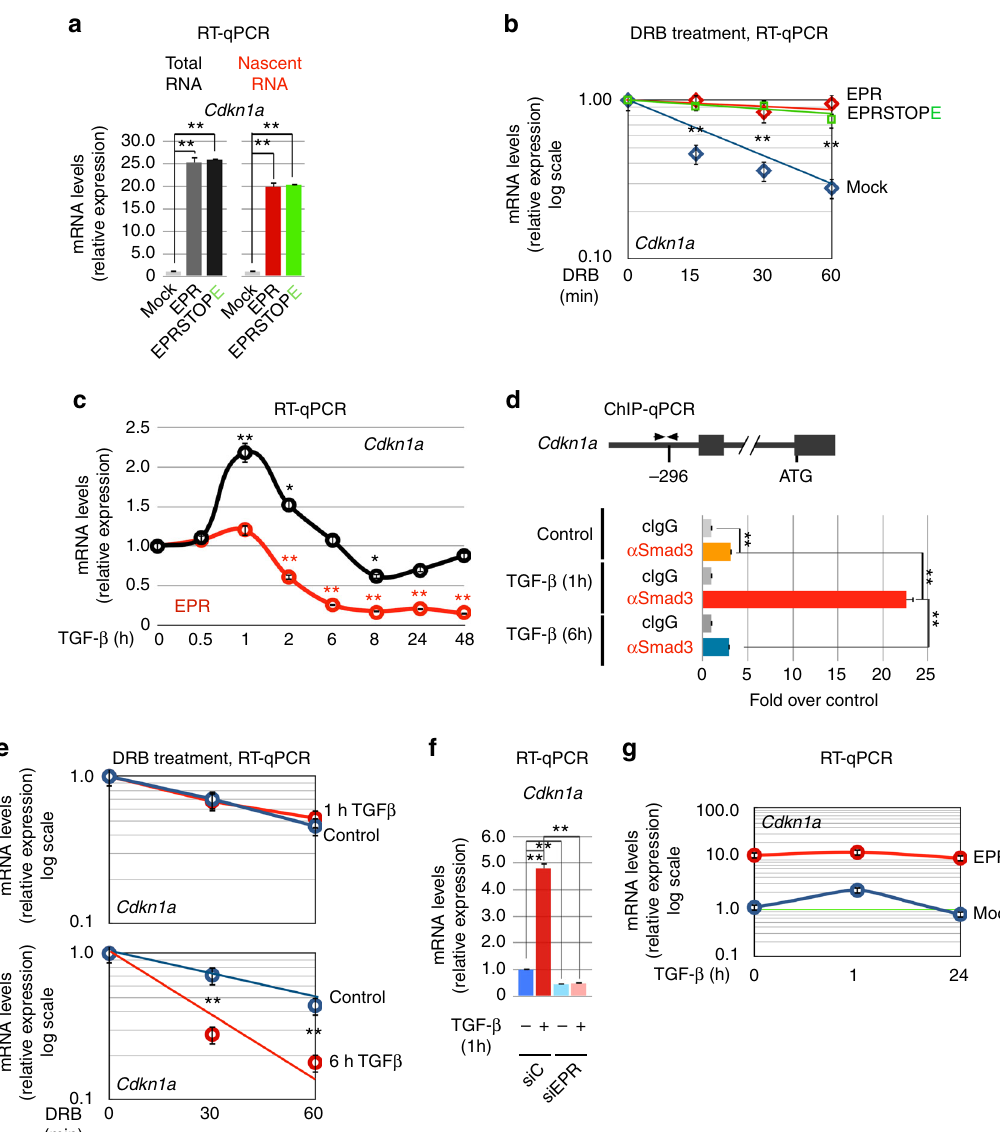
Fig. 4 Dual regulation of Cdkn1a gene expression by EPR. a qRT-PCR analysis of either total (left) or nascent (right) Cdkn1a transcript in either mock, EPR- or EPRSTOPE- overexpressing NMuMG cells. b Either mock, EPR- or EPRSTOPE-overexpressing NMuMG cells were treated with 100 μ M 5,6- dichlorobenzimidazole 1- β - D -ribofuranoside (DRB) for different times (as indicated). Cdkn1a gene expression was analyzed by qRT-PCR. c qRT-PCR analysis of Cdkn1a (black line) and EPR (red line) in NMuMG cells serum-starved (2% FBS, 16 h) and either treated with TGF- β (10 ng ml − 1 ) for the indicated times or untreated (time 0). d Chromatin prepared from NMuMG cells serum-starved and either treated with TGF- β for the indicated times or untreated (control) was immunoprecipitated using either control IgG or af fi nity-puri fi ed anti-SMAD3 rabbit polyclonal antibody. The association of SMAD3 with Cdkn1a promoter (schematic on the top) was quanti fi ed by qPCR (primers indicated as arrowheads in the schematic above). e NMuMG cells were serum- starved (2% FBS, 16 h) and either treated with TGF- β (10 ng ml − 1 ) for either 1 h (top panel) or 6 h (bottom panel) or left untreated (control in both panels). Subsequently, cells were treated with 100 μ M DRB for the indicated times and total RNA was isolated and analyzed by qRT-PCR to quantify Cdkn1a mRNA levels. Please note the slight, reproducible difference in the decay kinetic of Cdkn1a mRNA between nontransfected and mock-transfected NMuMG cells. f qRT-PCR analysis of Cdkn1a in NMuMG cells transiently transfected with either control siRNA (siC) or siRNA designed to silence EPR expression (siEPR), serum-starved (2% FBS, 16 h) and then either treated with TGF- β (10 ng ml − 1 ) for 1 h ( + ) or left untreated ( − ). g qRT-PCR analysis of Cdkn1a expression in either mock (blue line) or EPR overexpressing (red line) NMuMG cells serum-starved (2% FBS, 16 h) and either treated with TGF- β (10 ng ml − 1 ) for the indicated times or left untreated (time 0). Please note the logarithmic scale of the Y- axis. The values of both qRT-PCR and qPCR experiments shown are averages (±SEM) of three independent experiments performed in triplicate. Statistical signi fi cance: * p < 0.01, ** p < 0.001 (Student ’ s t